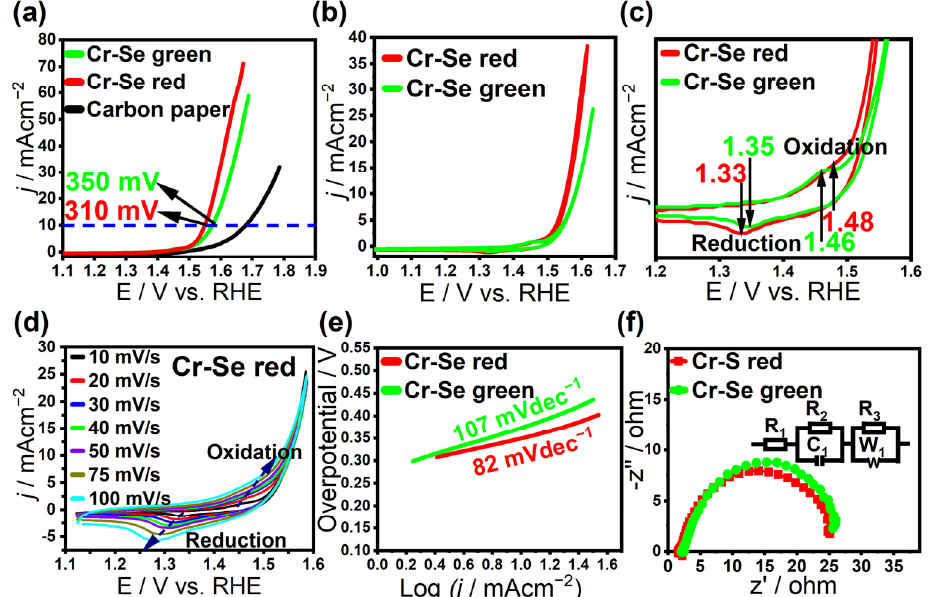
Figure 4. Electrocatalytic performance of Cr–Se red and Cr–Se green complexes. ( a ) Linear scan voltammetry showing overpotential at 10 mA/cm 2 . ( b ) Cyclic voltammetry. ( c ) The Cr(III) and Cr(VI) redox potentials for Cr–Se red and green complexes. ( d ) Cyclic voltammograms of Cr–Se red complex measured at scan rates from 10 to 100 mV/s. ( e ) Tafel plots. ( f ) Electrochemical impedance spectroscopy (EIS) showing Nyquist plots in the AC frequency range between 100 kHz and 0.1 Hz, at 1.55 V vs. RHE. Inset shows the fi tt ed equivalent circuit.